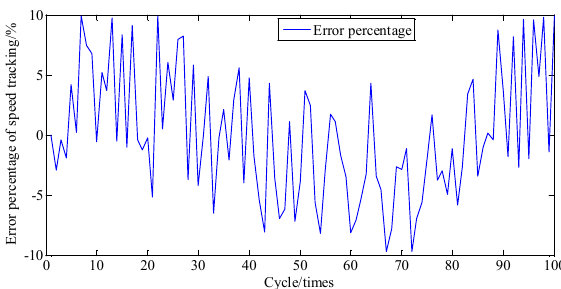
Table 2. Parameters of the 24th order Fourier series.